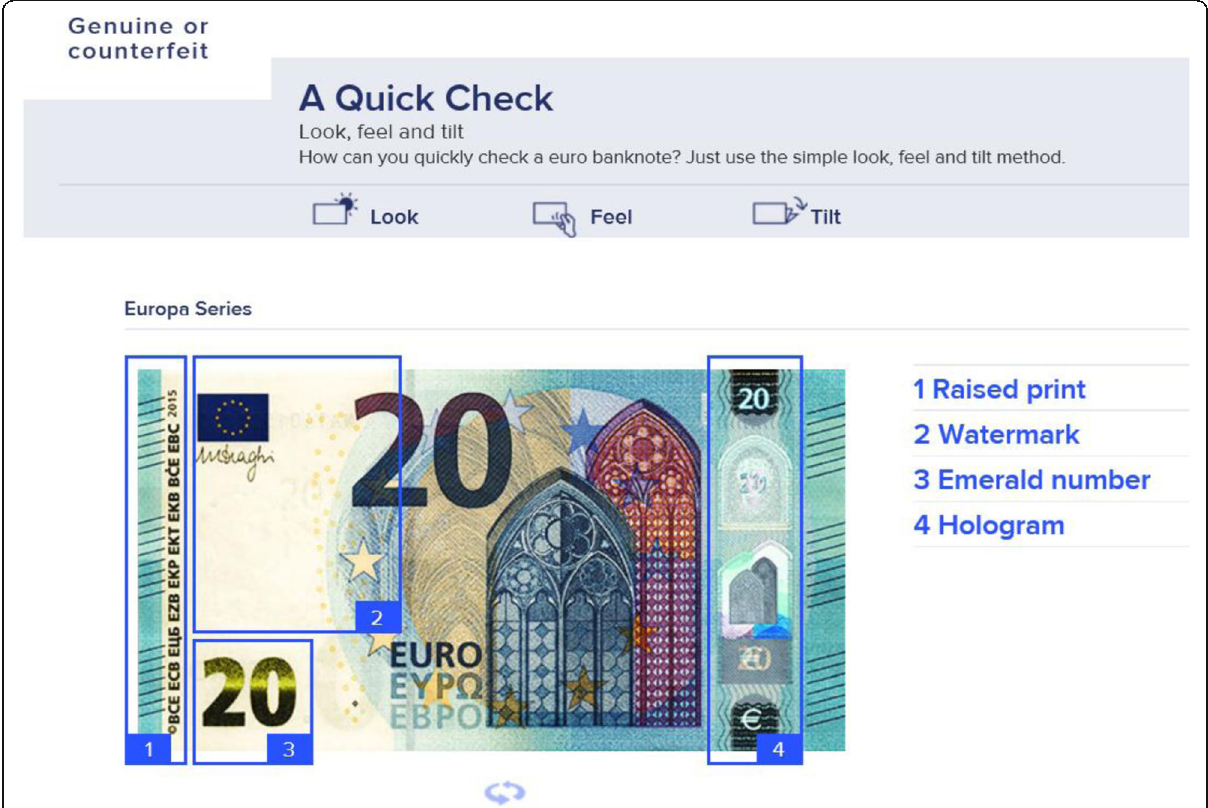
Fig. 1 Security features for the public shown on the De Nederlandsche Bank (DNB) website